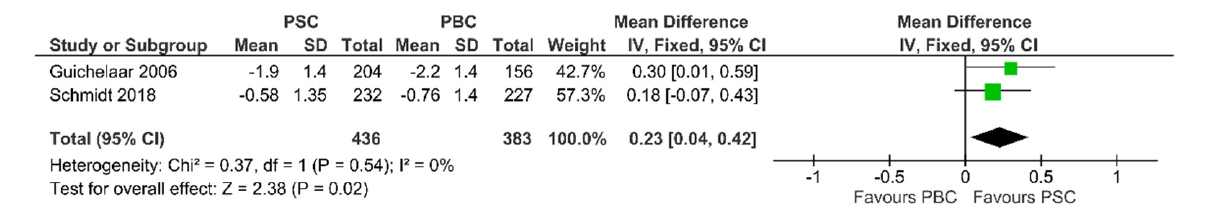
Figure 4. Forest plot assuming a fixed-effects model for T-score PSC vs. PBC [30,33].